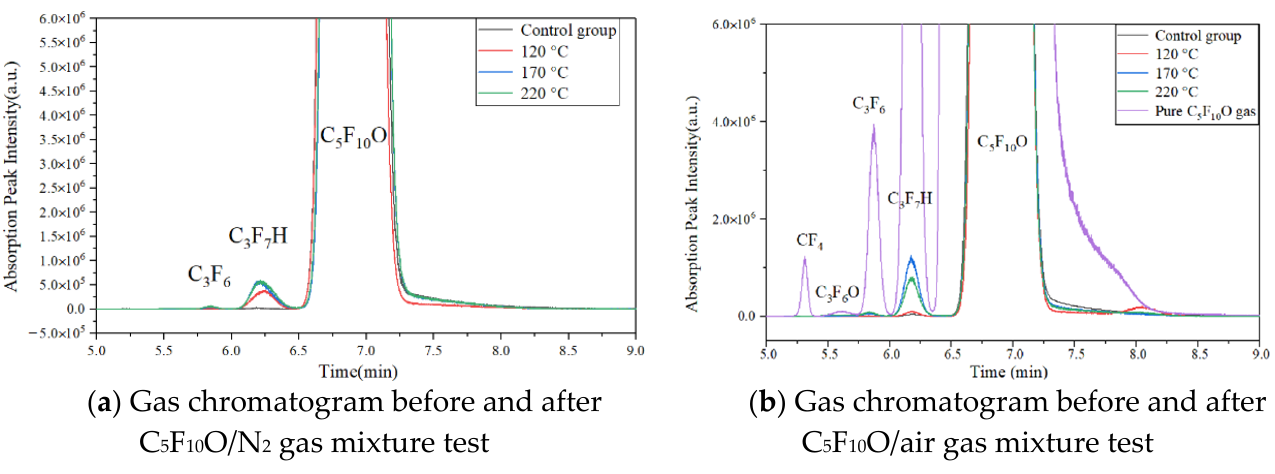
Figure 4. Gas chromatogram of C 5 F 10 O gas. Table 1. C 5 F 10 O gas and its decomposition product mass-to-charge ratios ( m / z ) and separation